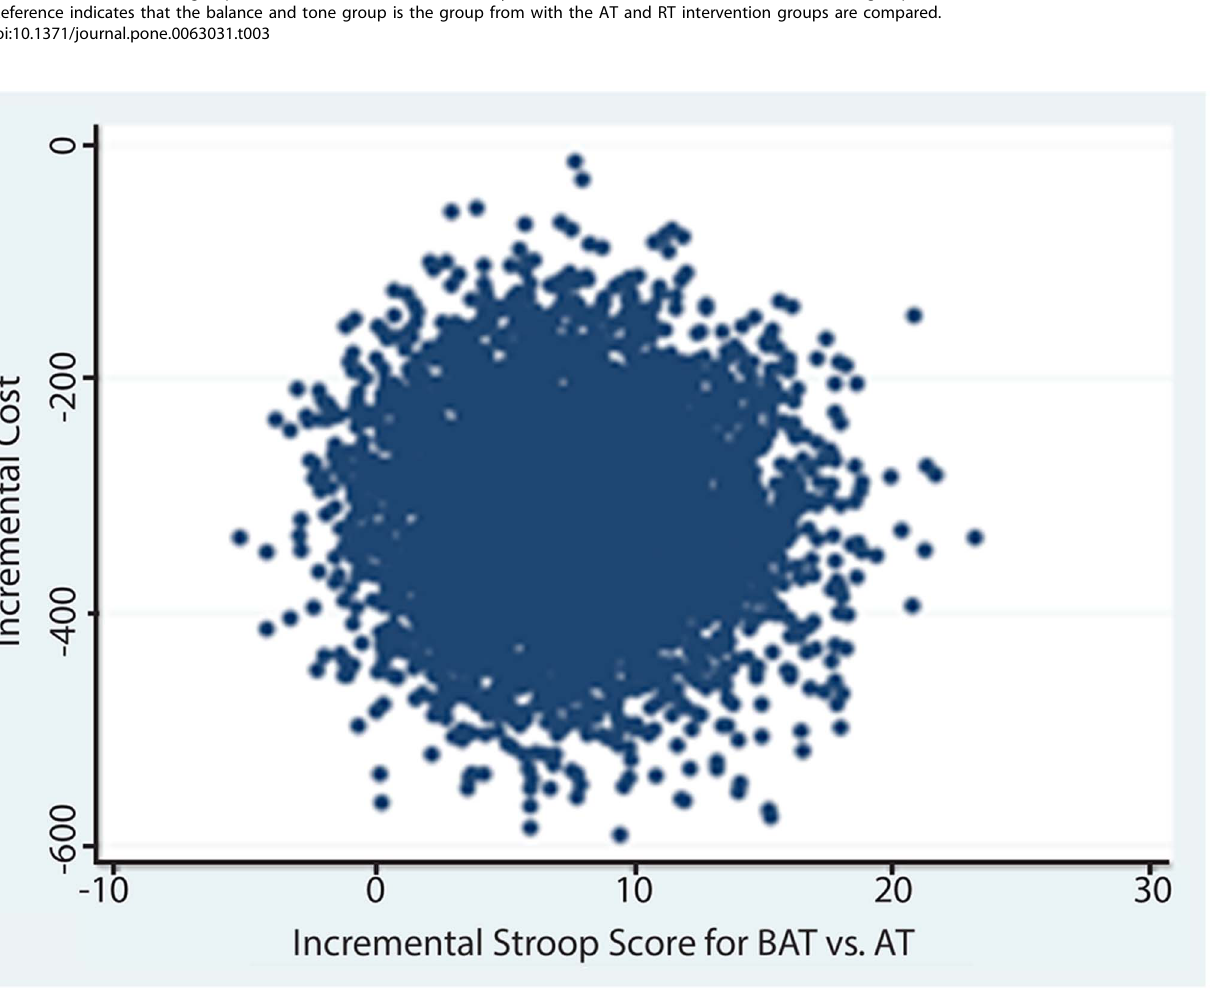
Figure 1. Cost effectiveness plane depicting scatterplot of bootstrapped estimates of incremental cost and effectiveness for comparison between AT and